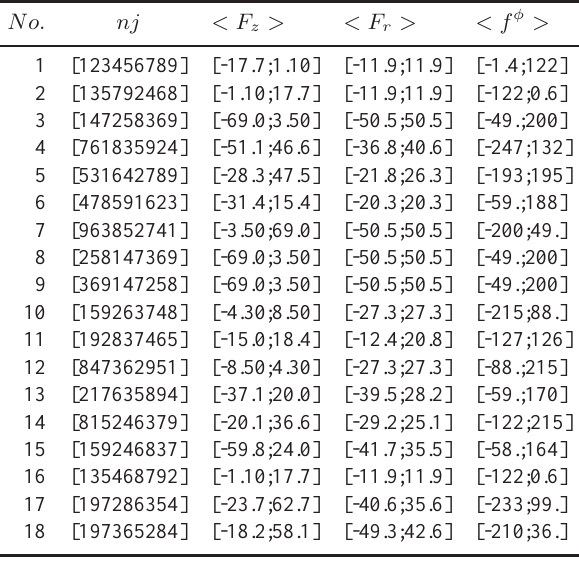
Table 1. The extreme values of averaged forces and curl of